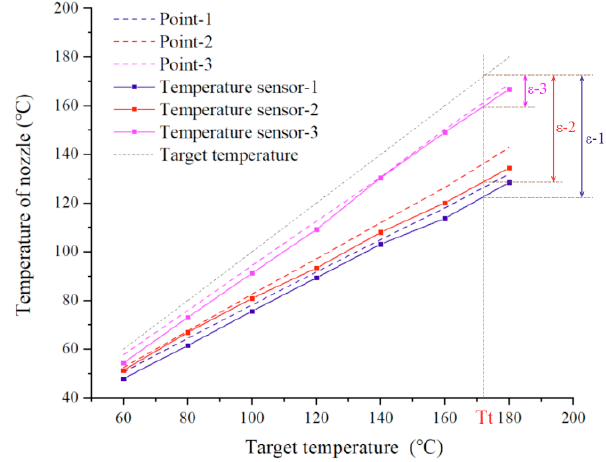
Figure 7. Measurement of temperature at the